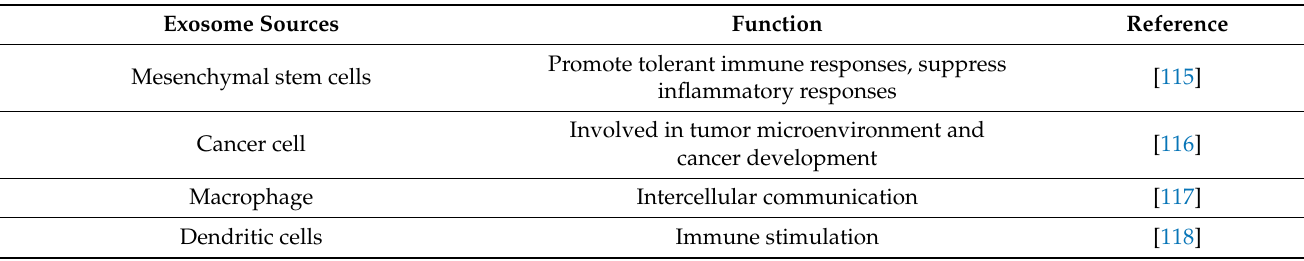
Table 3. Exosomes derived from